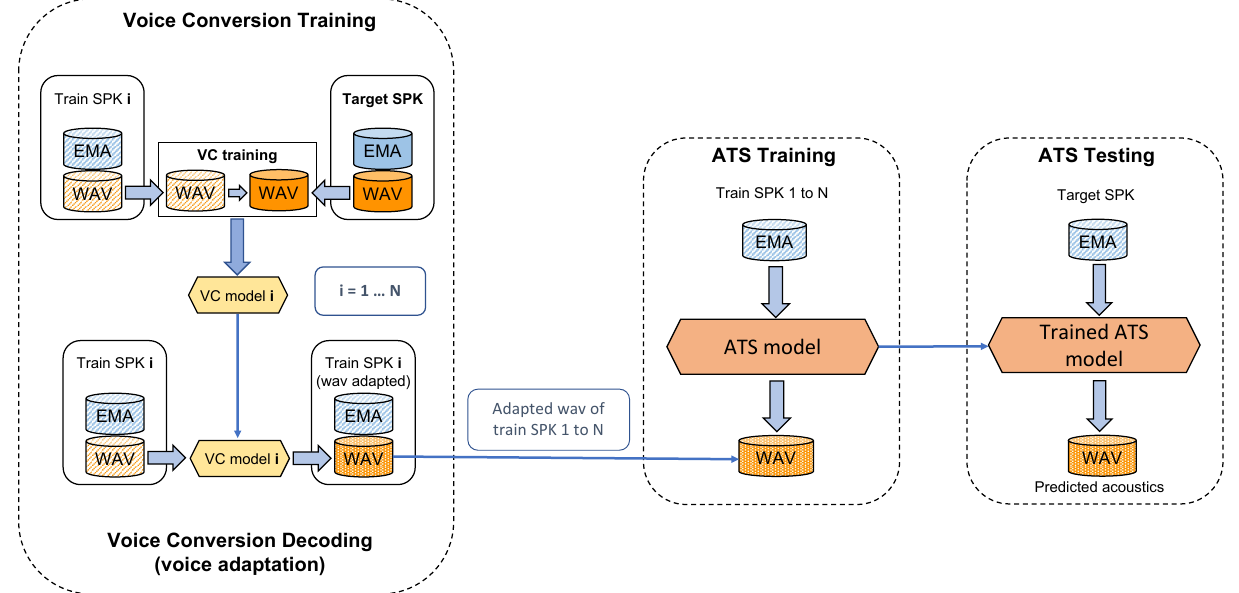
Figure 2. The pipeline of ATS Speaker adaptation using voice conversion. For each target speaker, the other N (seven) speakers were training